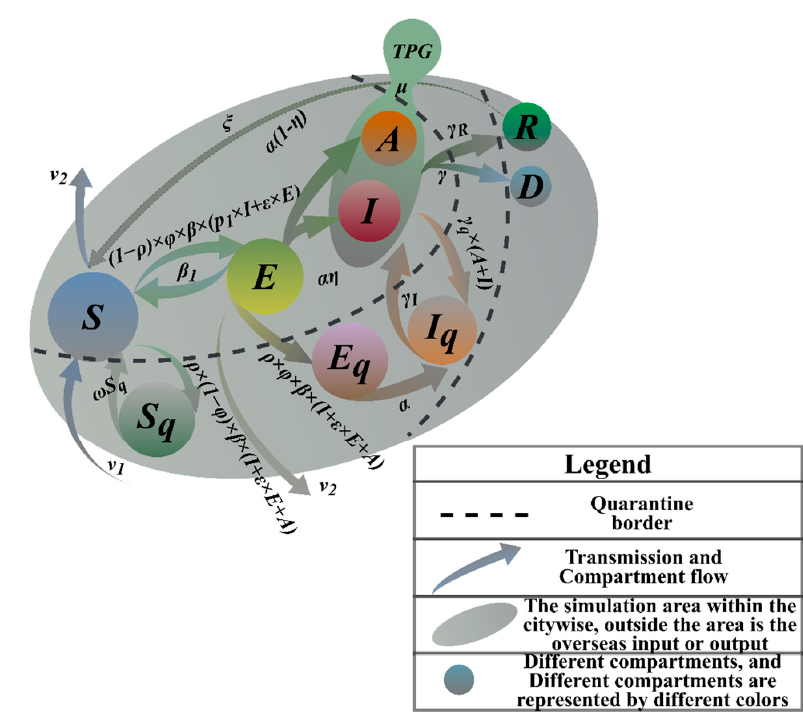
Figure 1. SETPG (A + I) RD + APT Imitation Dynamics Model Frame Diagram.